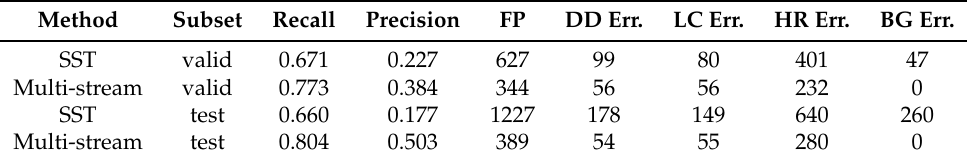
Table 4. Analysis of multi-stream and SST results based on the four different types of false-positive (FP) errors, as described in Figure 12.